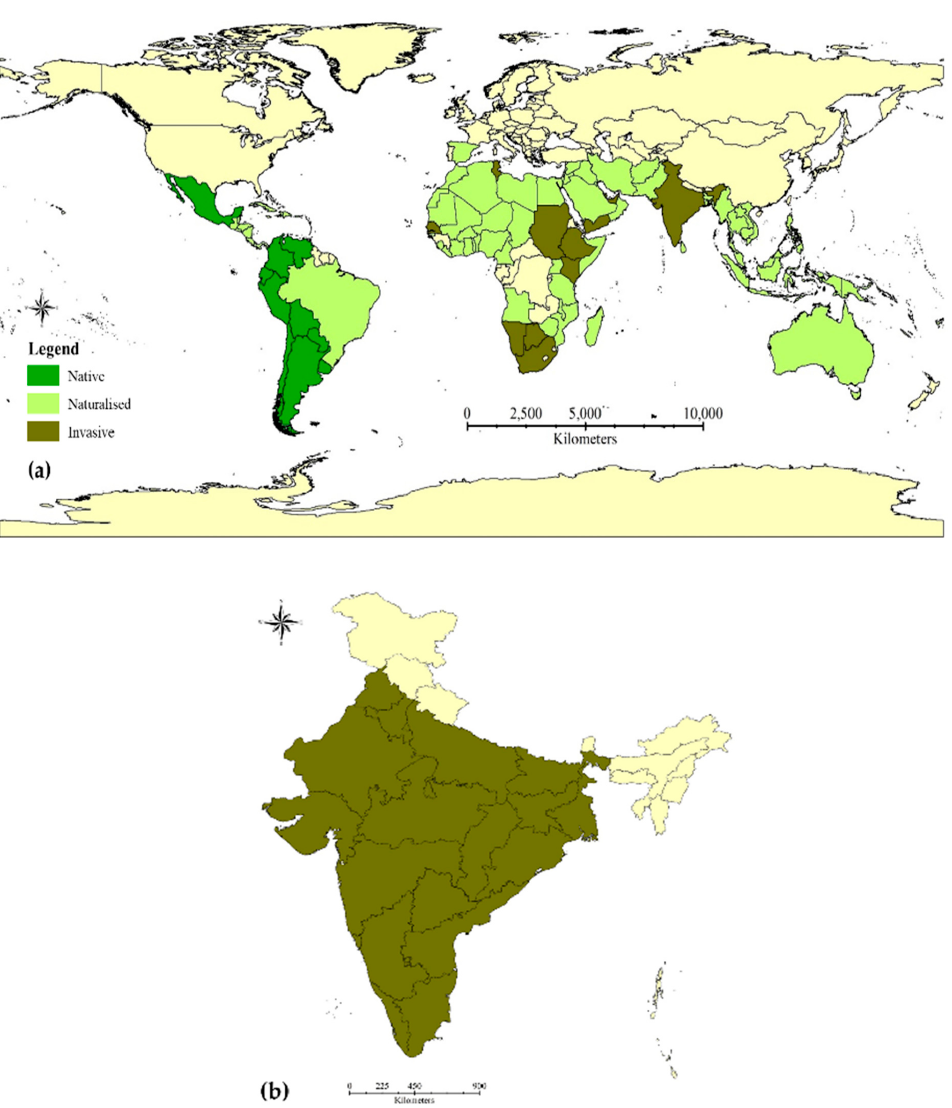
Figure 2. ( a ) Global distribution of P. juliflora showing its native range, naturalised habitat and the areas facing the risk of invasion, ( b ) Invasion status of P. juliflora in